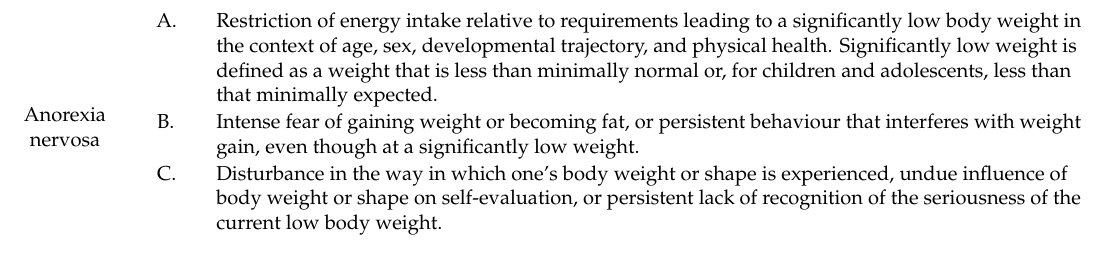
Table 1. Diagnostic criteria of anorexia nervosa according to DSM-5 classification.